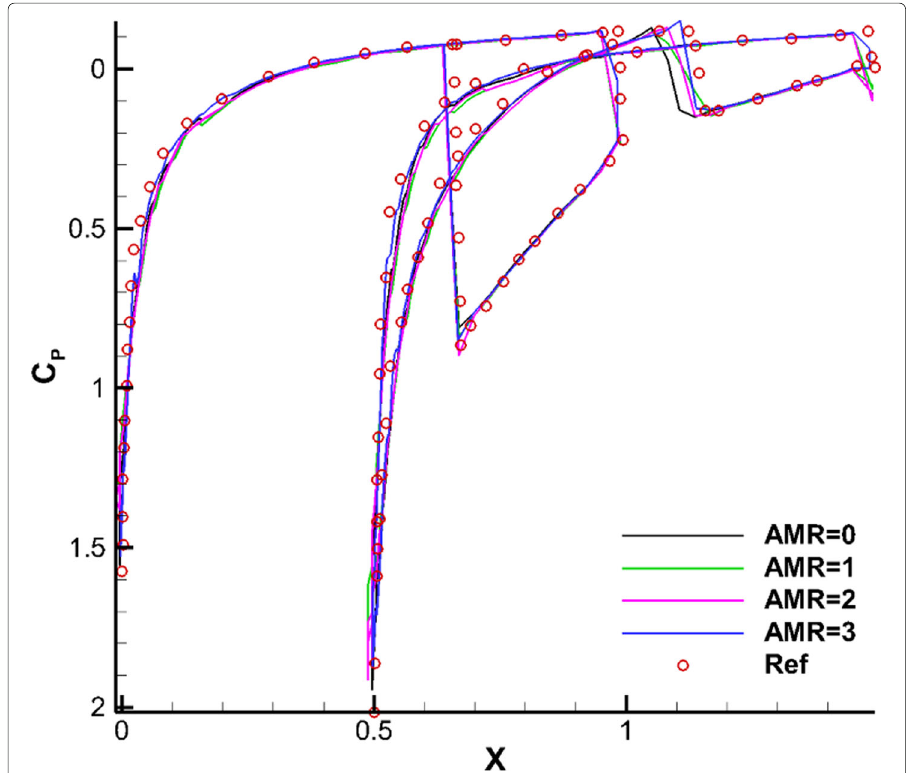
Fig. 16 Simulated surface pressure coefficient distributions obtained with different levels of refinement for the inviscid flow over two staggered NACA0012